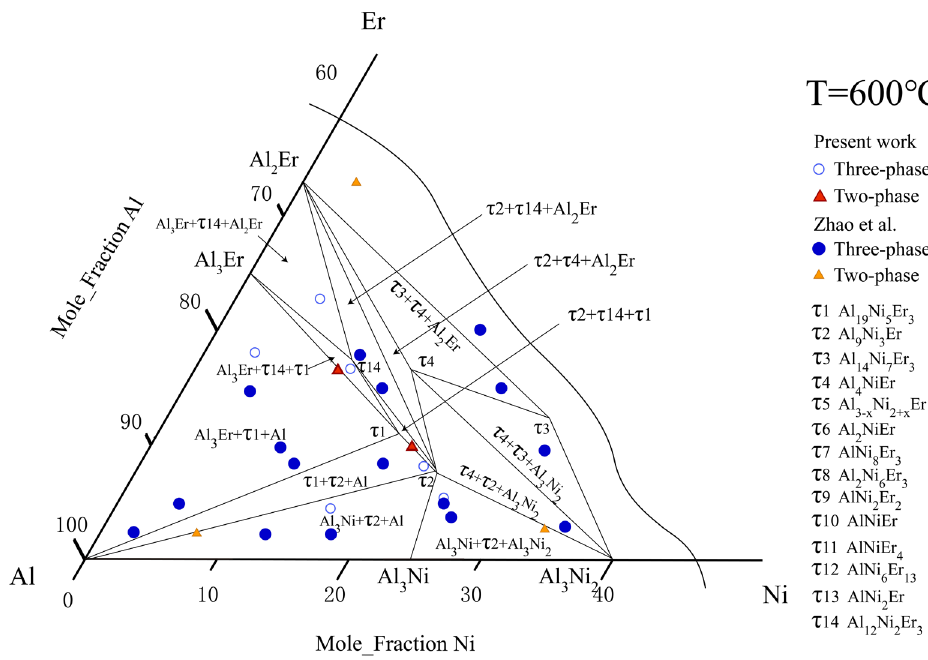
Figure 16. Calculated isothermal sections of the Al–Ni–Er ternary system at 600 °C compared with experimental data from this work and Zhao et al. [34].